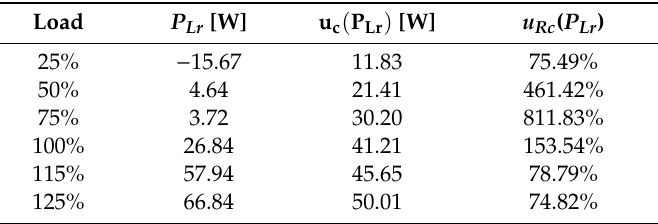
Table 3. Experimental results: residual losses with